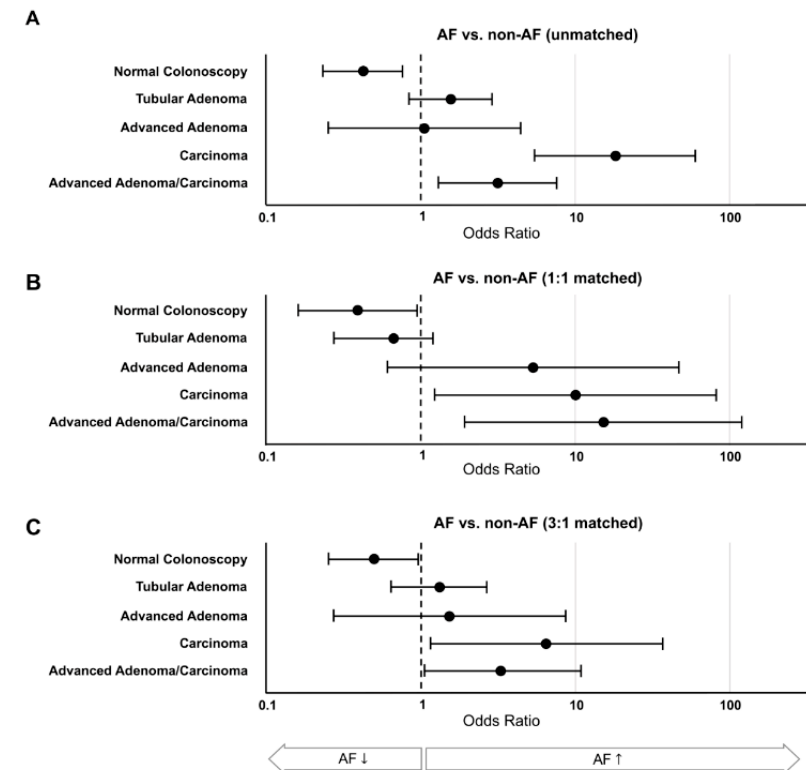
Figure 2. CRC (colorectal cancer) Screening Results. Comparing AF (atrial fibrillation) and non-AF participants ( A unmatched, B 1:1 matched and C 3:1 matched), odds ratios for a normal colonoscopy, tubular adenoma (benign), advanced adenoma (premalignant), and carcinoma were calculated. The odds ratio for a combined endpoint of advanced adenoma and carcinoma was calculated because of its clinical significance. While normal colonoscopy was more significantly common in non-AF controls, there was a significantly increased risk of advanced neoplasias in AF participants across all comparisons.